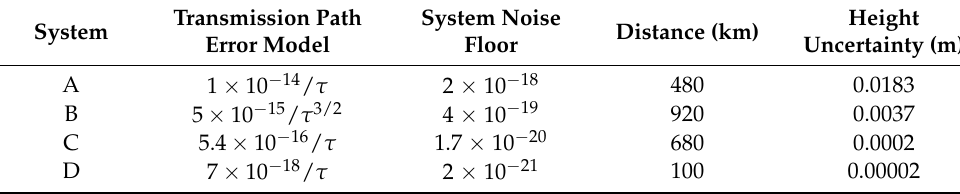
Table 3. Transmission path error and parameters of existing OFFT